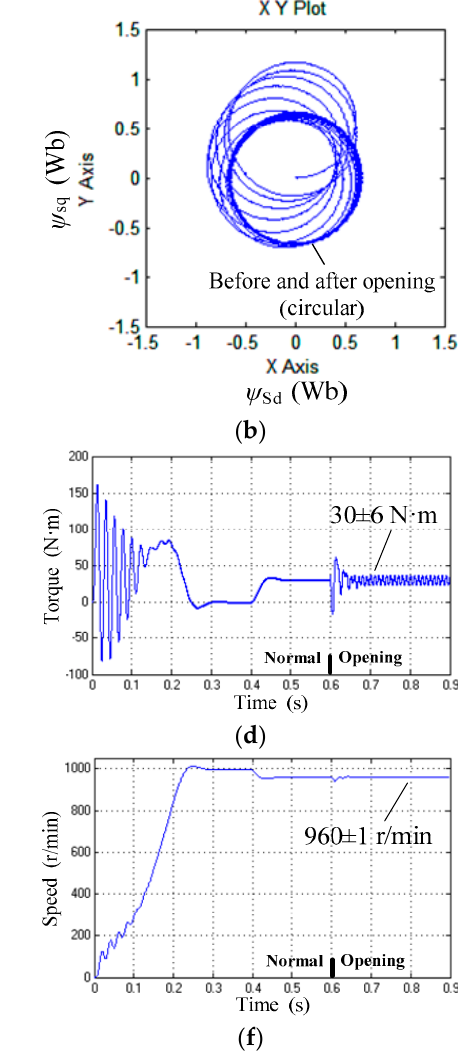
Figure 11. Stator winding currents in simulations 1 and 2. ( a ) Stator winding currents in simulation 1; ( b ) Stator winding currents in simulation 2; ( c ) ACE-winding currents in simulation 1; ( d ) ACE- winding currents in simulation 2; ( e ) BDF-winding currents in simulation 1; ( f ) BDF-winding currents in simulation 2.